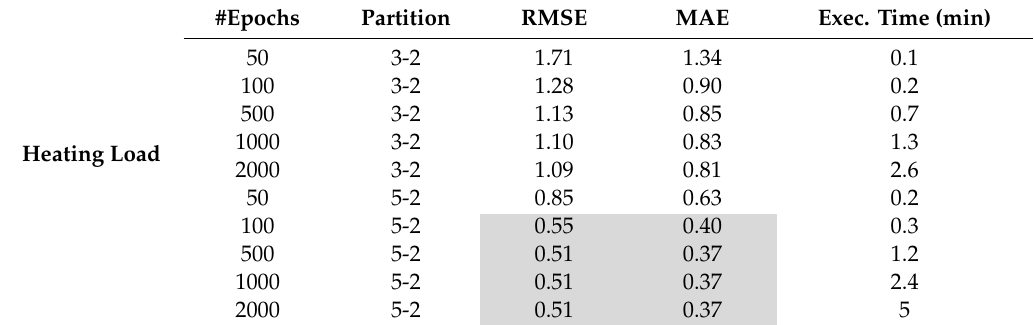
Table 3. Prediction errors obtained by ANFIS for the HL, when the features selected by FIR are used as input variables, that is, RC and GA. The best prediction performances are highlighted.